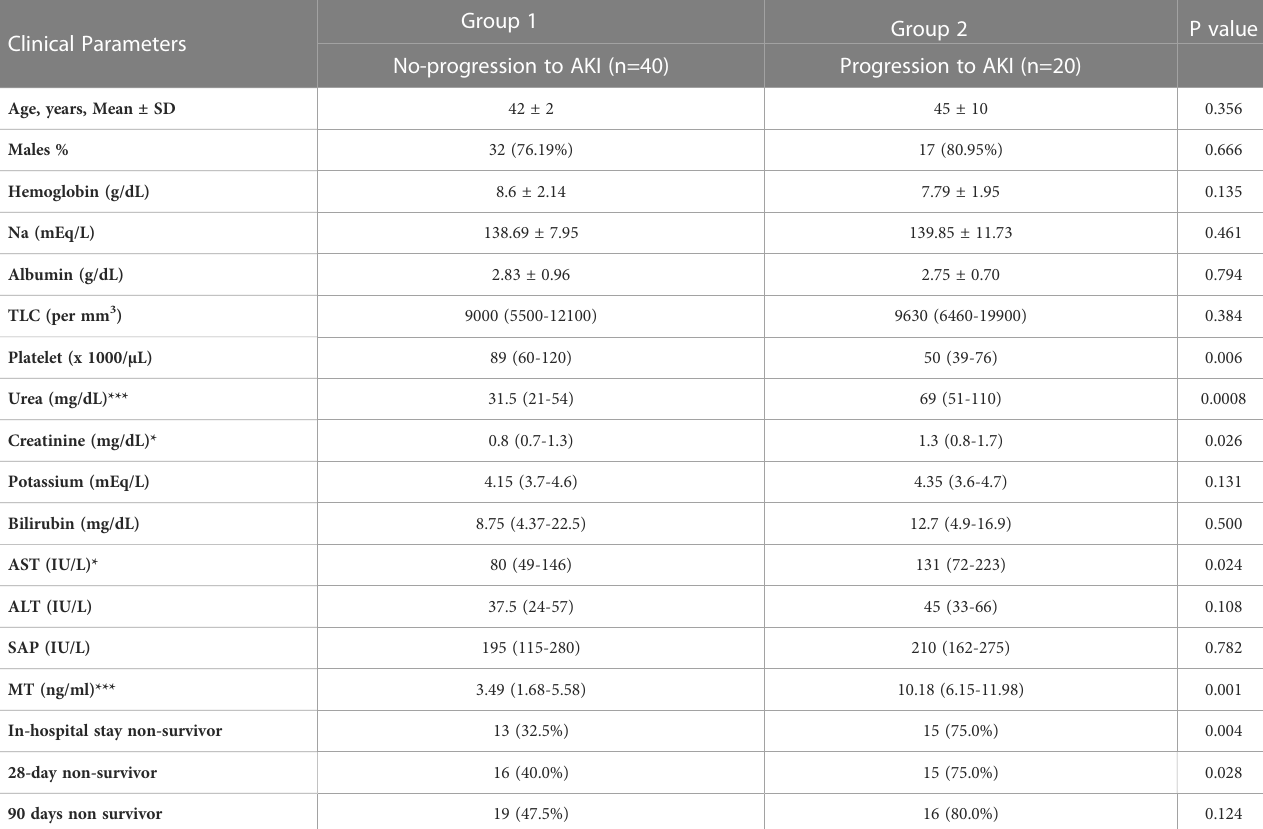
TABLE 4 Baseline characteristics of ACLF patients who progress to AKI and who ACLF patients who do not progress to AKI.